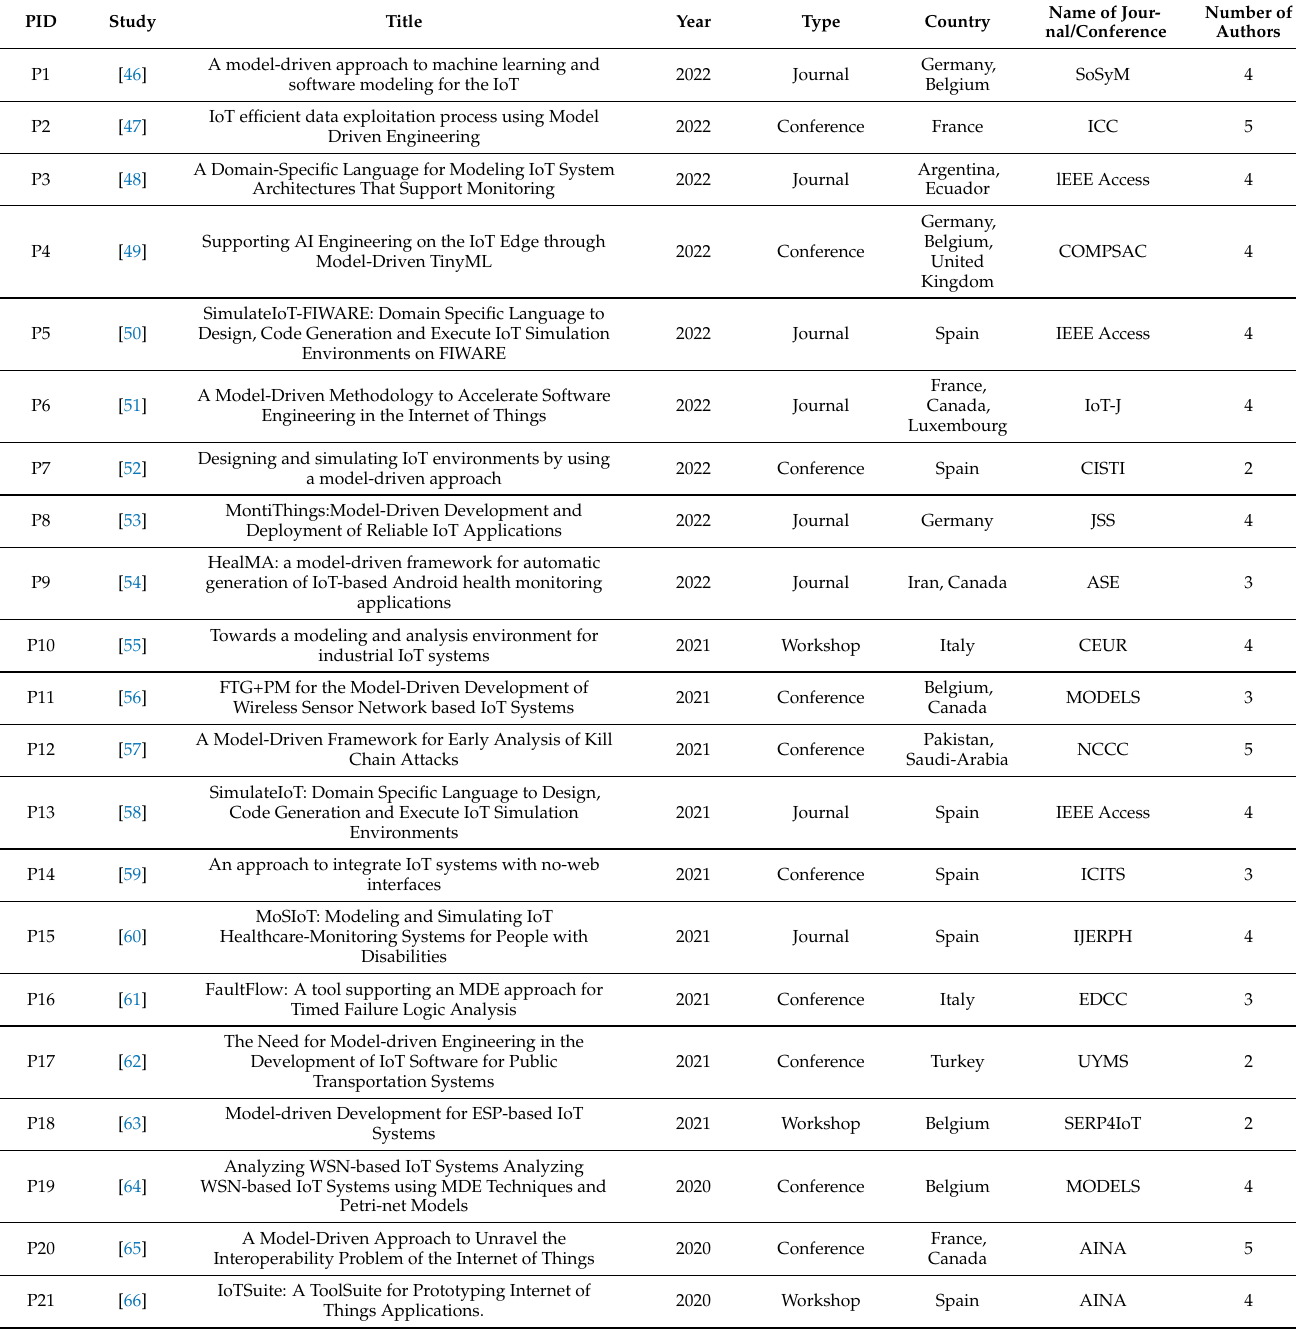
Table A1. Included studies in the scoping